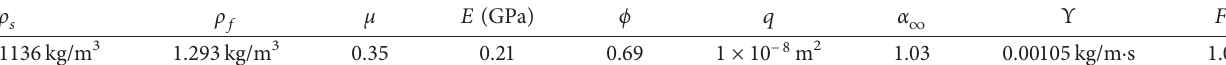
Table 4: Parameters of the limp frame porous rotational shell.